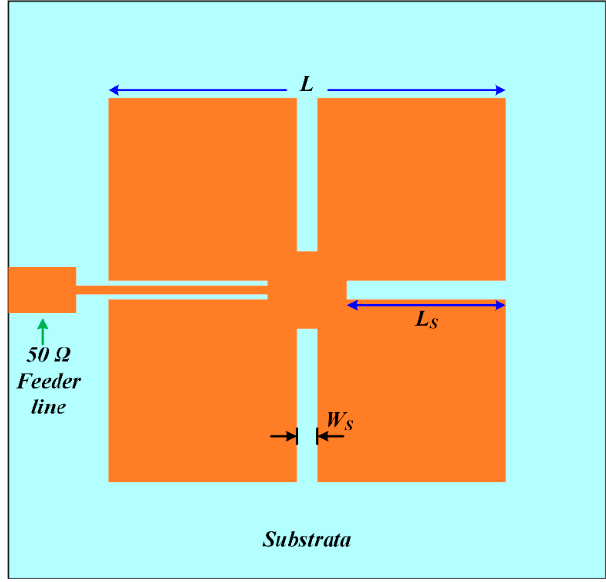
Figure 3. The slotted antenna with inset fed along the X -axis.